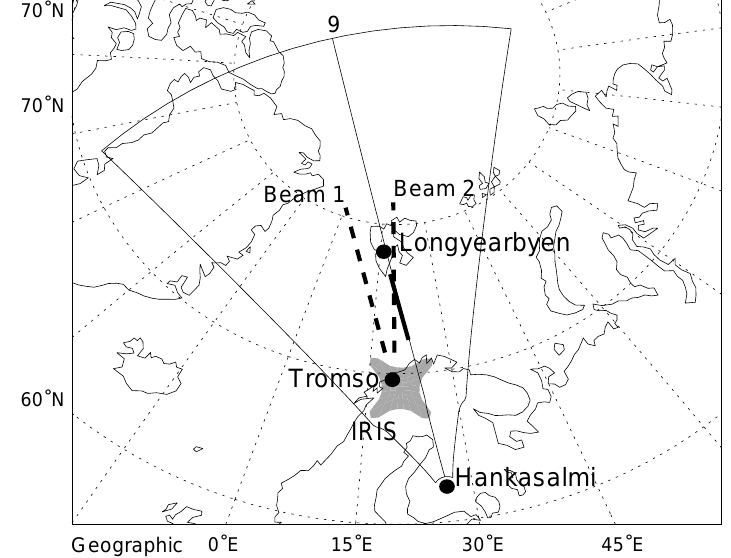
Fig. 1. The instrumentation used in the study. The field-of-view of the Hankasalmi radar is shown, with beam 9 marked explicitly with a line. The EISCAT VHF and ESR beam positions for the SP-UK-CSUB experiment are marked with heavy lines, and the IRIS riometer field-of-view is indicated by a shaded